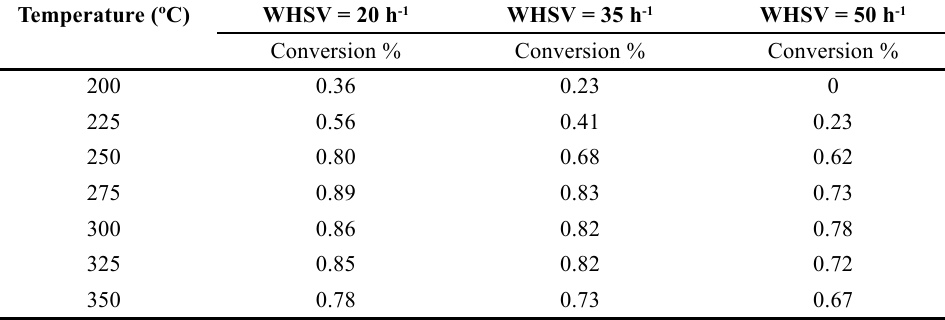
Table.2 . Experimental data for dehydration of methanol over Al-B catalyst